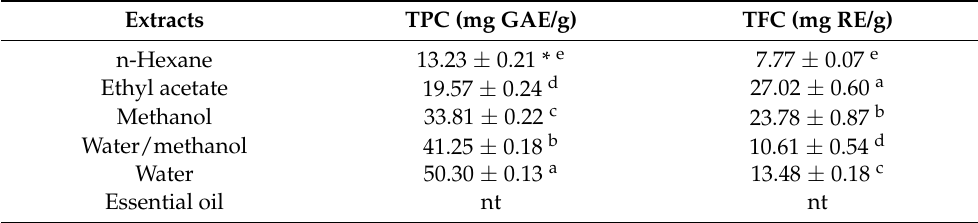
Table 1. Total bioactive compounds and total antioxidant capacity (by phosphomolybdenum assay) of the tested